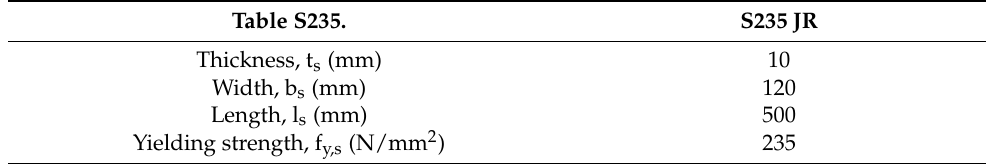
Table 1. Properties of steel plates according to EN 1993-1-1:2006 [24]. Table